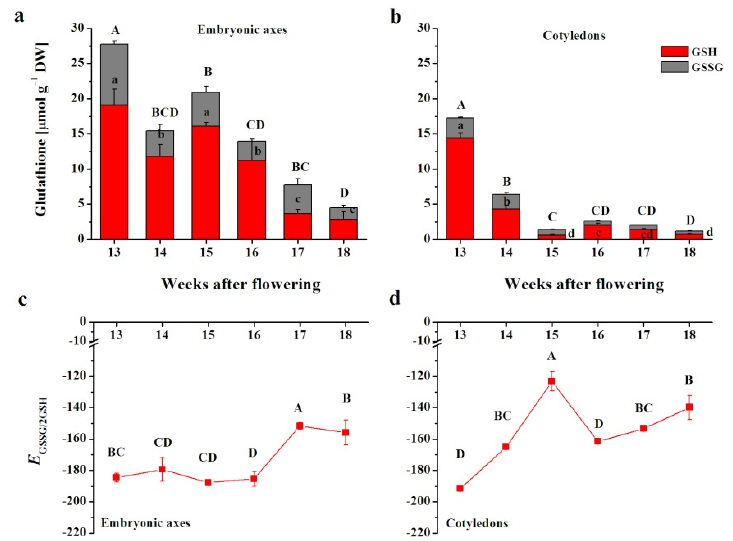
Figure 2. Levels of the reduced form of glutathione (GSH) and its oxidized form glutathione disulfide (GSSG) ( a , b ) and the half-cell reduction potential of glutathione ( E GSSG/2GSH ) ( c , d ) in embryonic axes ( a , c ) and cotyledons ( b , d ) of developing beech seeds. Data are the means of three independent replicates ± the standard error. Statistically significant differences are indicated with different letters (one-way ANOVA, followed by Tukey’s test at p < 0.05). The capital letters refer to GSSG.